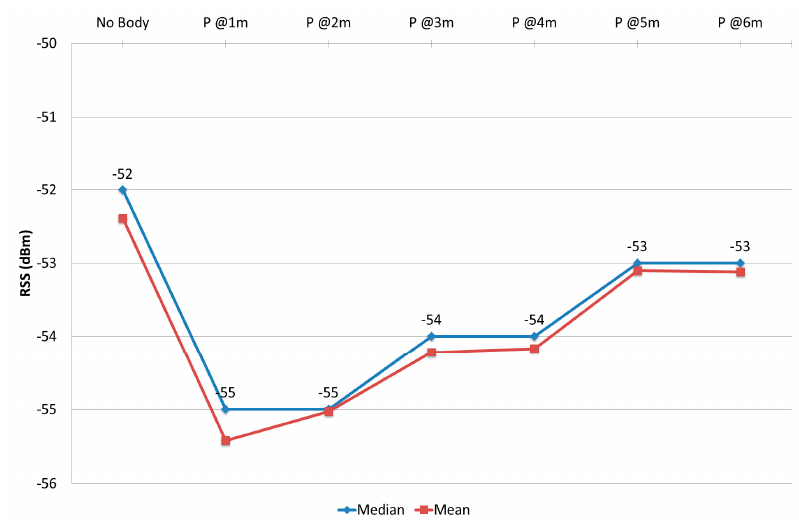
Figure 19. PPE in HLOS RSS centroid values.